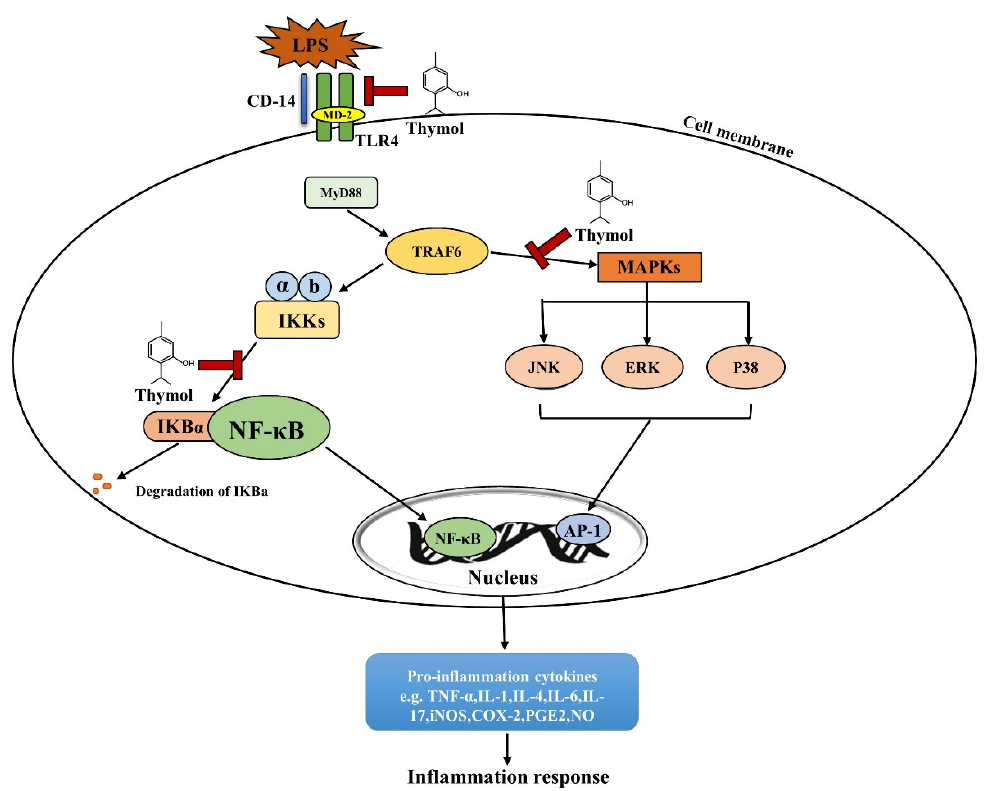
Figure 3. Mechanism of thymol in relieving inflammation. Cells receive various stimuli and activate I κ B kinases (I κ Ks) through the TLR4 signaling pathway, and then I κ B proteins are phosphorylated, ubiquitinated, and degraded, and NF- κ B dimers are released. The NF- κ B dimer is then further activated through various post-translational modifications and translocated into the nucleus to bind to target genes to promote pro-inflammatory gene transcription. In addition, by activating the MAPKs family, it can promote the expression of c-jun terminal kinases (JNK) 1/2, extracellular signal-regulated kinase (ERK), and p38 for activation, thereby promoting the nuclear entry of activator protein 1 (AP-1) to regulate the expression of pro-inflammatory genes. Thymol inhibits the dissociation of the I κ B protein and NF- κ B dimer and the activation of the mitogen-activated protein kinase (MAPK) signaling pathway to relieve inflammation.